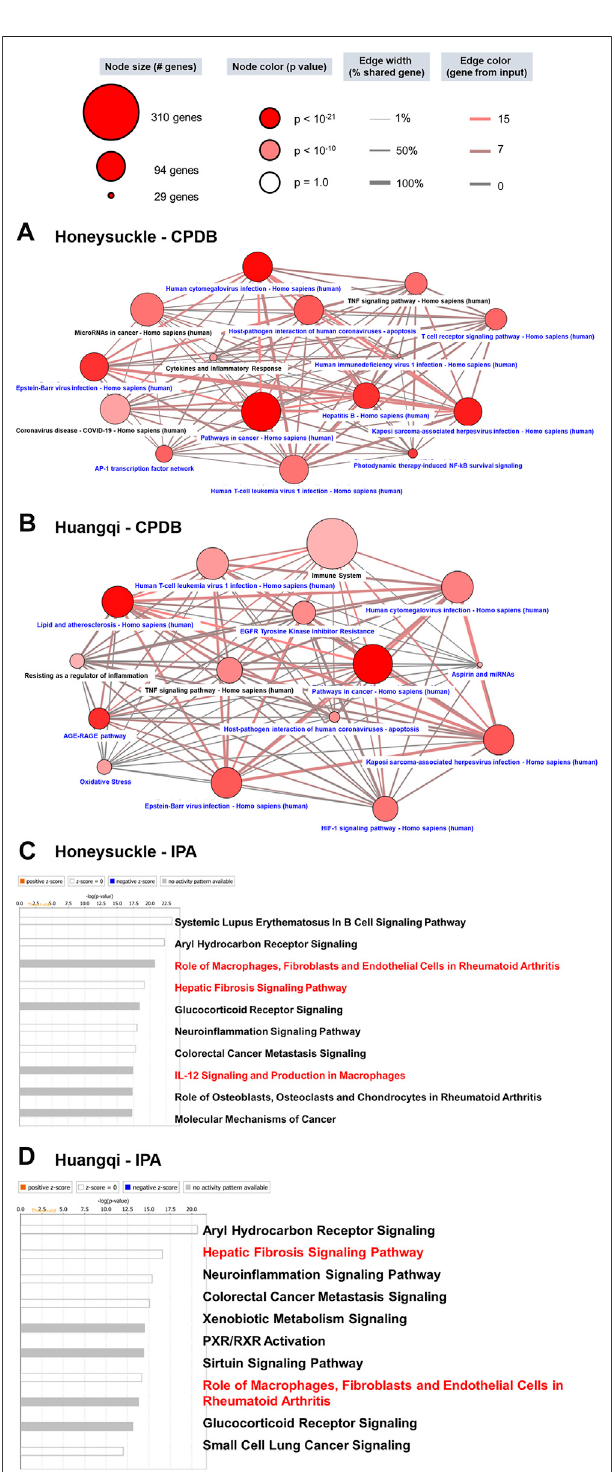
FIGURE 2 | The potential mechanism of Honeysuckle ( Lonicera japonica ) and Huangqi ( Astragalus membranaceus ) via the bioinformatics work fl ow. (A) According to the results of the FDR-BH statistical analysis, we selected 66 signi fi cant honeysuckle targets to perform enrichment analysis via CPDB. To begin, 15 pathways were selected from the top 150